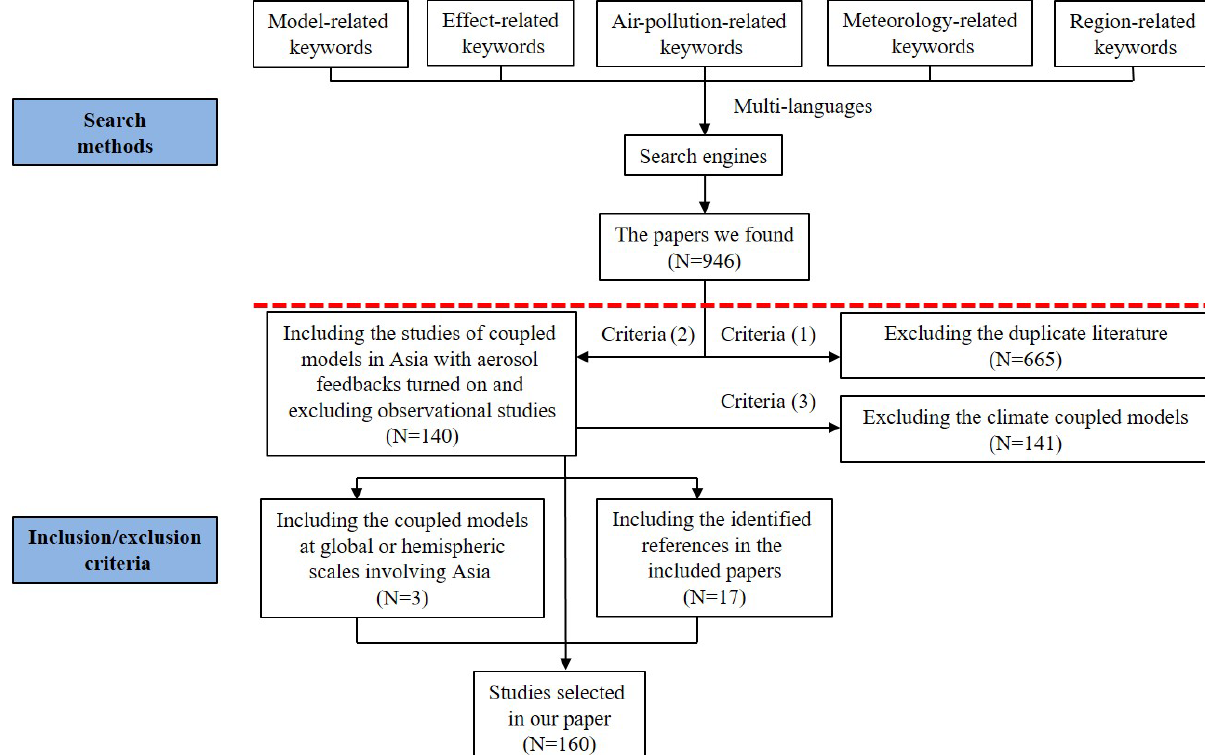
Figure A1. Flowchart of literature search and